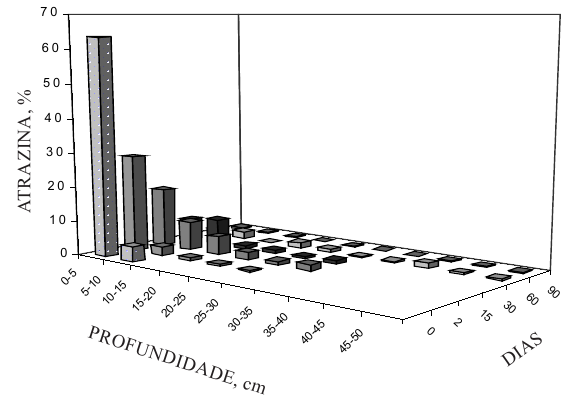
Figura 6. Distribuição da atrazina em diferentes profundidades do solo em 90 dias de experimen- to.